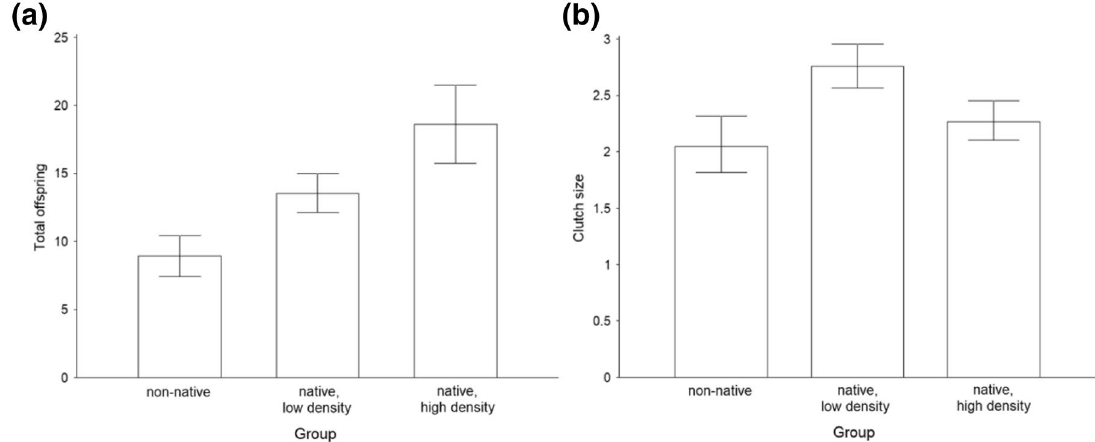
Figure 2. ( a ) Clutch size (i.e. offspring per parasitized host egg) and ( b ) total number of offspring per female A. flavipes under different conditions: fictitious host plant with 50% rate of an unsuitable host (broad-leaved dock,